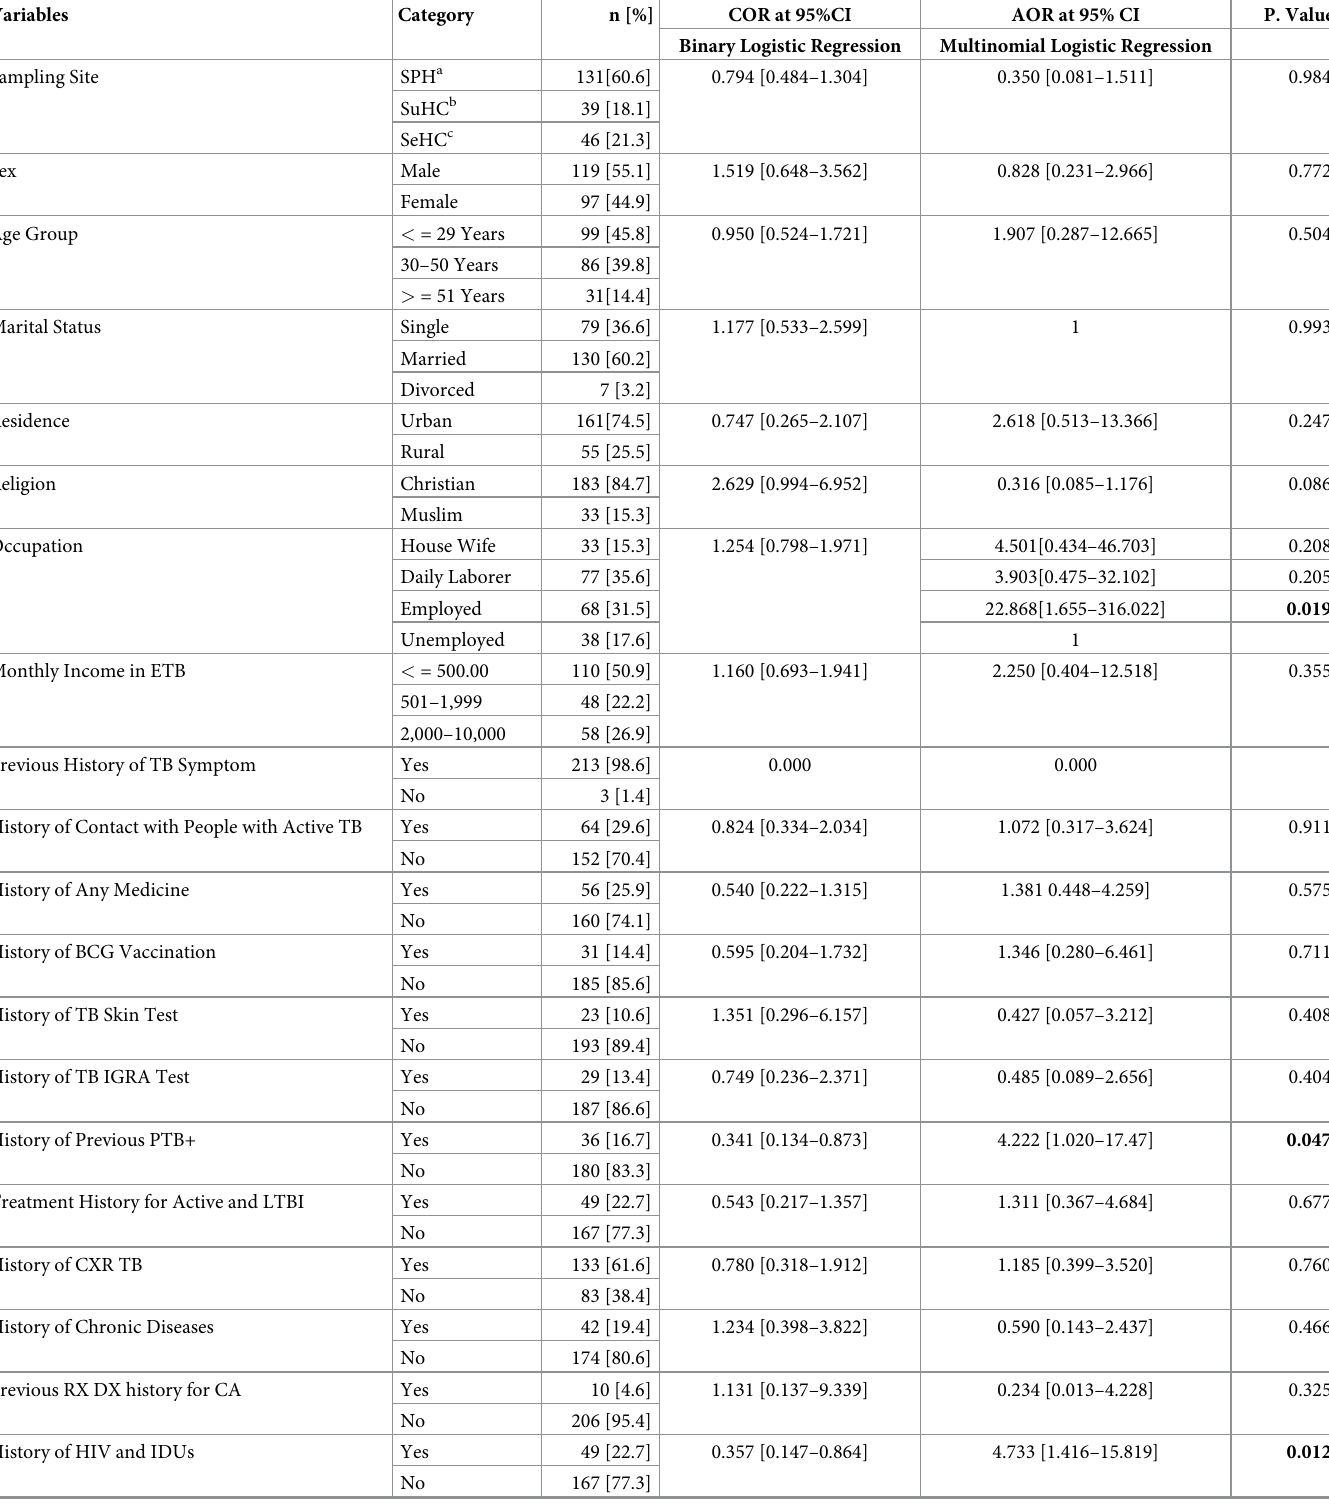
Table 2. Factors associated with the outcome variables of RR TB, MTBC patients in Addis Ababa from October 2019 to March